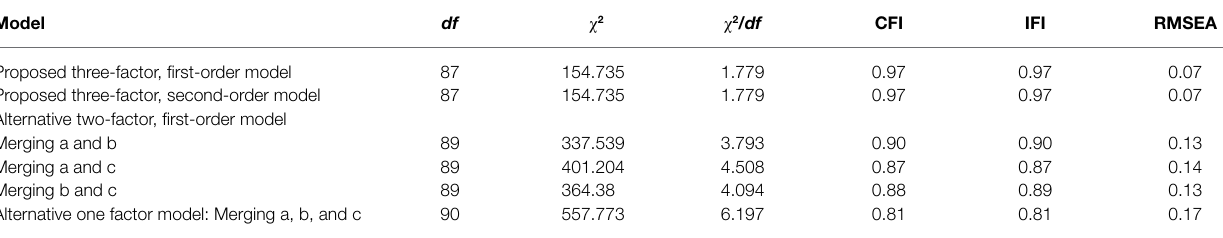
TABLE 2 | Measurement model